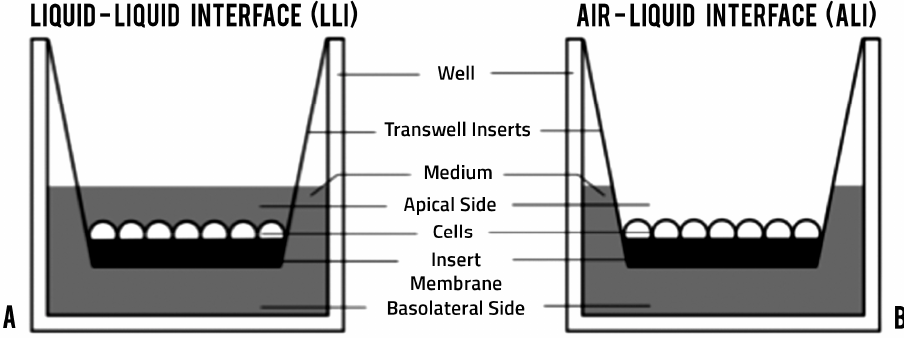
Figure 1. Culture design comparison. ( A ) liquid ‐ liquid interface (LLI); ( B ) air ‐ liquid interface